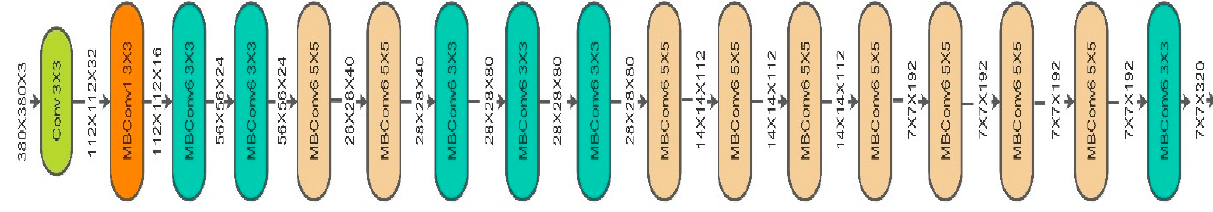
9 of 23 Figure 5. Visual illustration of data augmentation step. 3.4. E ffi cientNet-B0 Pre-Trained Model E ffi cientNet uses a compound coe ffi cient to scale both the design and sizing of its convolutional neural network. This compound coe ffi cient uniformly scales the depth, width, and resolution parameters to maintain consistency throughout the network. Un- like the traditional approach of unconstrained scaling of these parameters, the E ffi cient- Net scaling approach employs a fi xed set of scaling coe ffi cients to uniformly adjust the